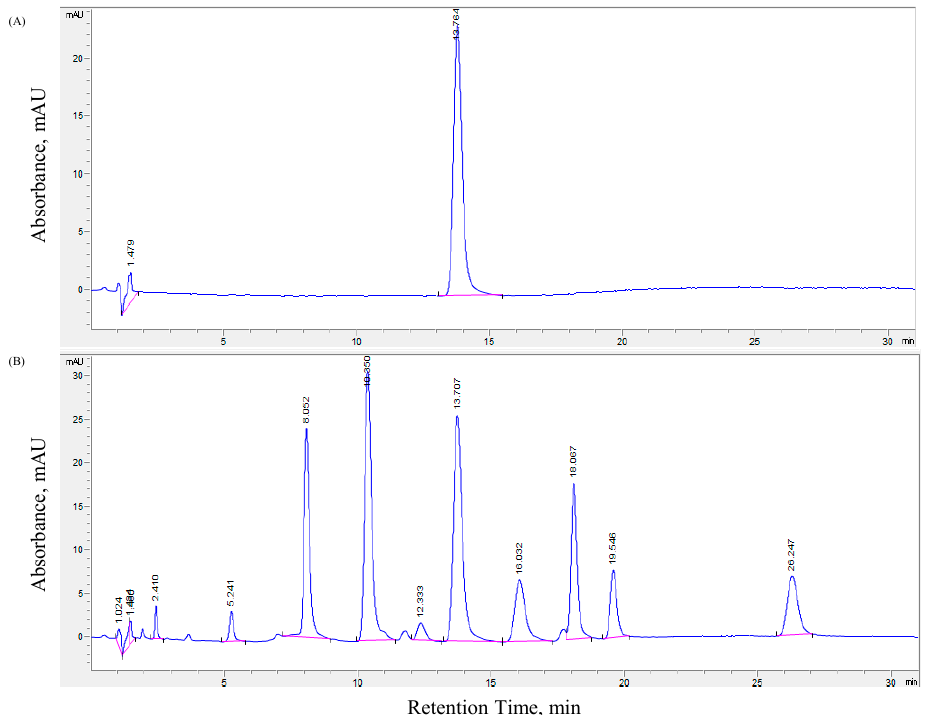
Figure 1. ( A ) Chromatogram of standard vanillyl butyl ether. ( B ) Typical chromatogram of vanillyl butyl ether in tiger balm eluted at 13.728 min. Table 3. Concentration of vanillyl butyl ether in commercial cosmetic product.